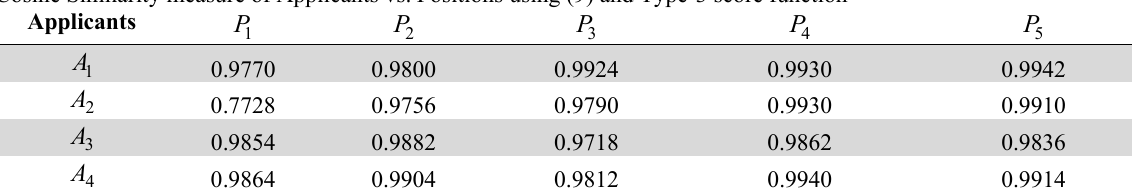
Cosine Similarity measure of Applicants vs. Positions using (9) and Type-3 score